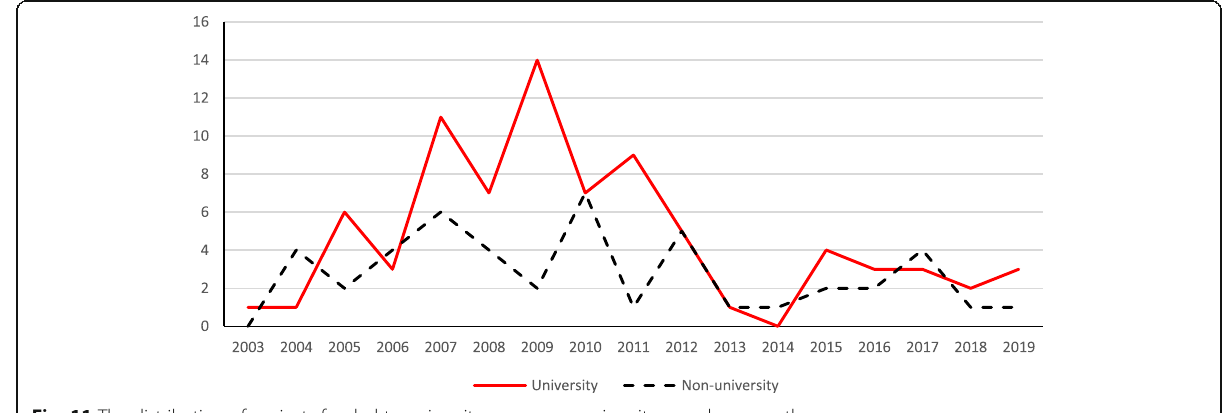
Fig. 11 The distribution of projects funded to university versus non-university awardees over the